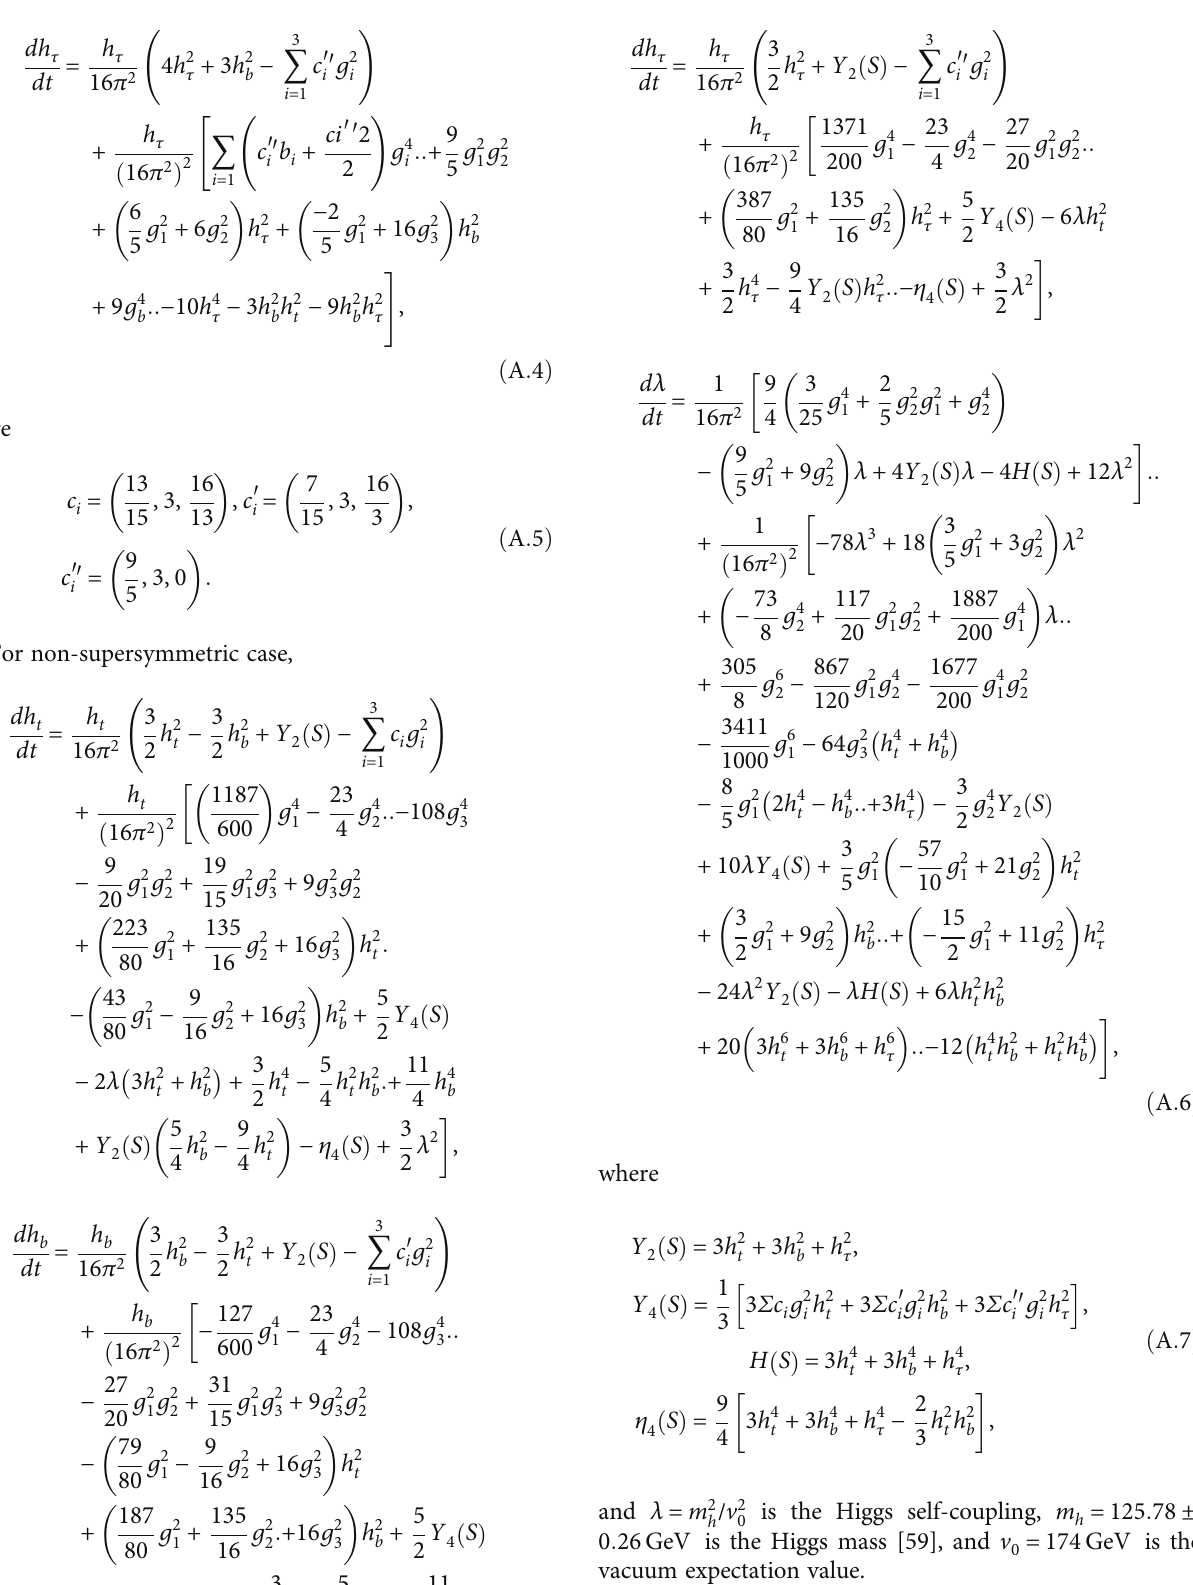
The beta function coe ffi cients for non-SUSY case are given